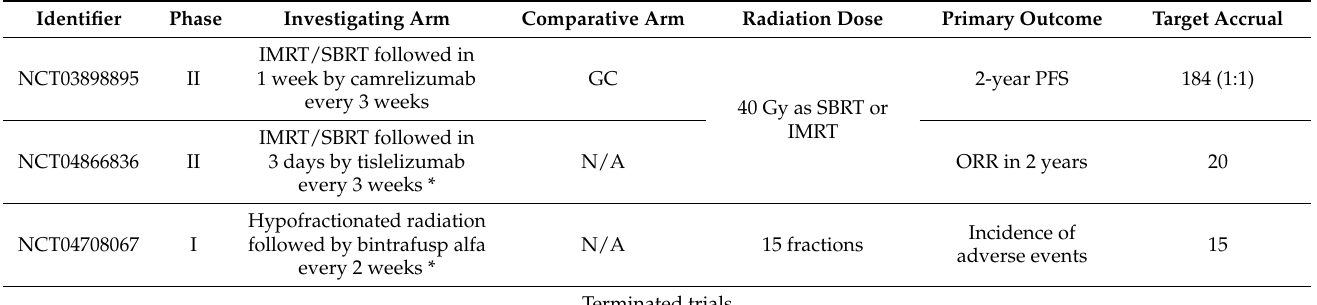
Table 3. Active Trials for Stereotactic Body Radiation Therapy and Immune-Checkpoint Inhibitors in